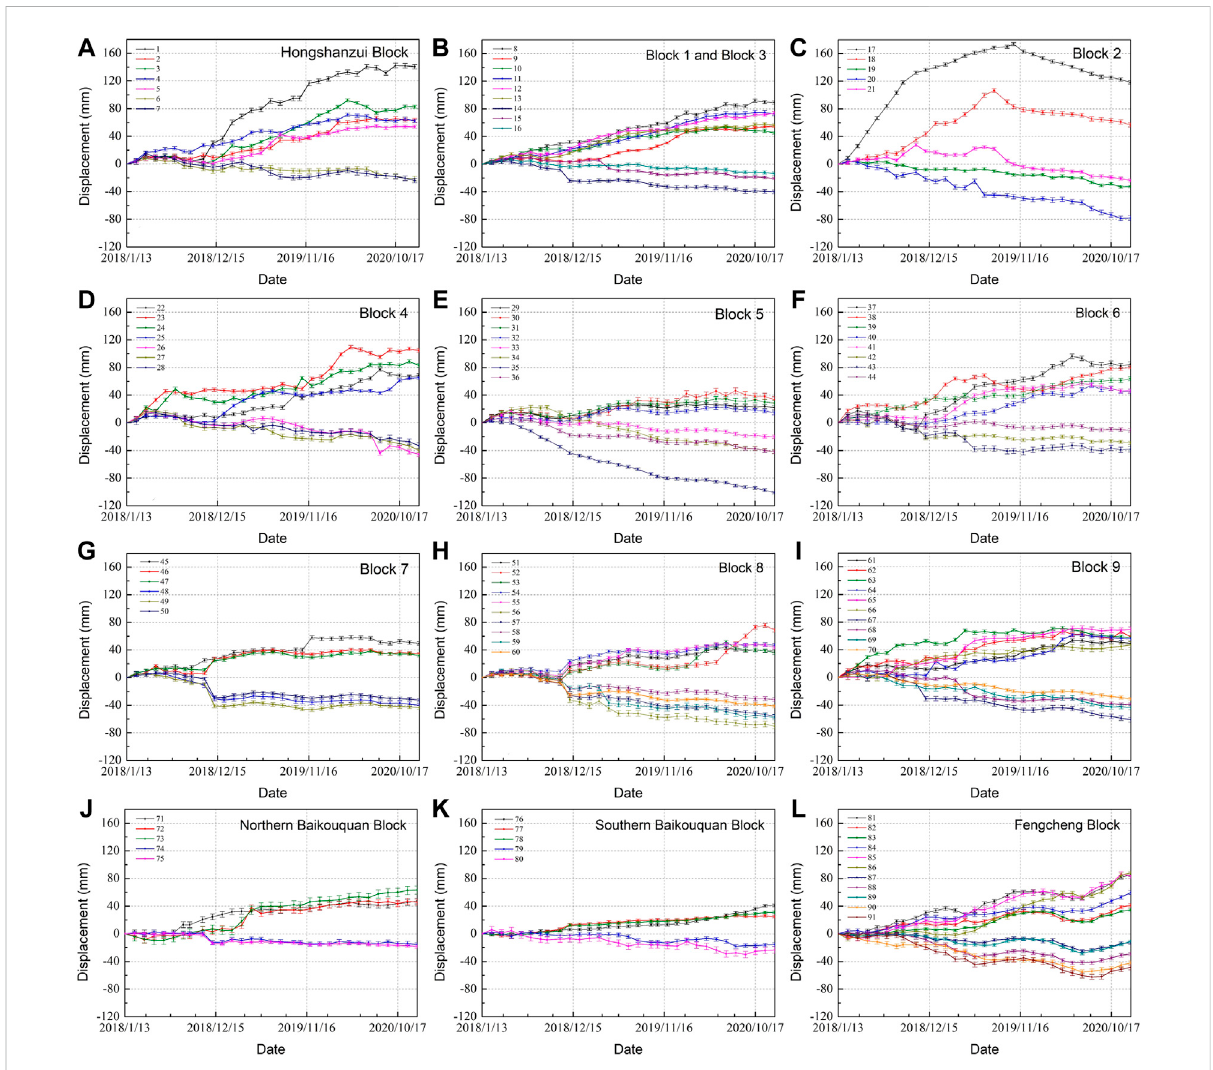
FIGURE 4 Time series deformation curves of the 91 deformation points in different blocks from January 2018 to December 2020. The positions of the 91deformation pointsare showninFigure 3.Each deformation curveisplottedwith error bars,representingthemeanstandarddeviation ofaverage deformation